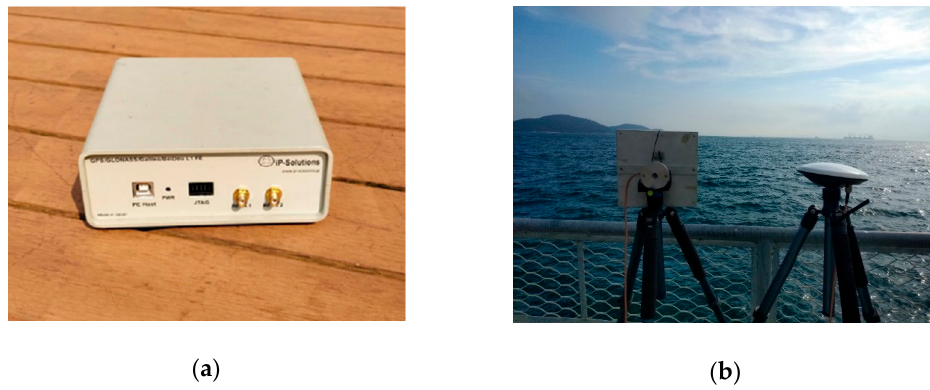
Figure 10. Photographs of hardware: ( a ) is the receiver front-end, and ( b ) is the direct and reflected antenna. Table 2. Experimental and signal processing parameters.